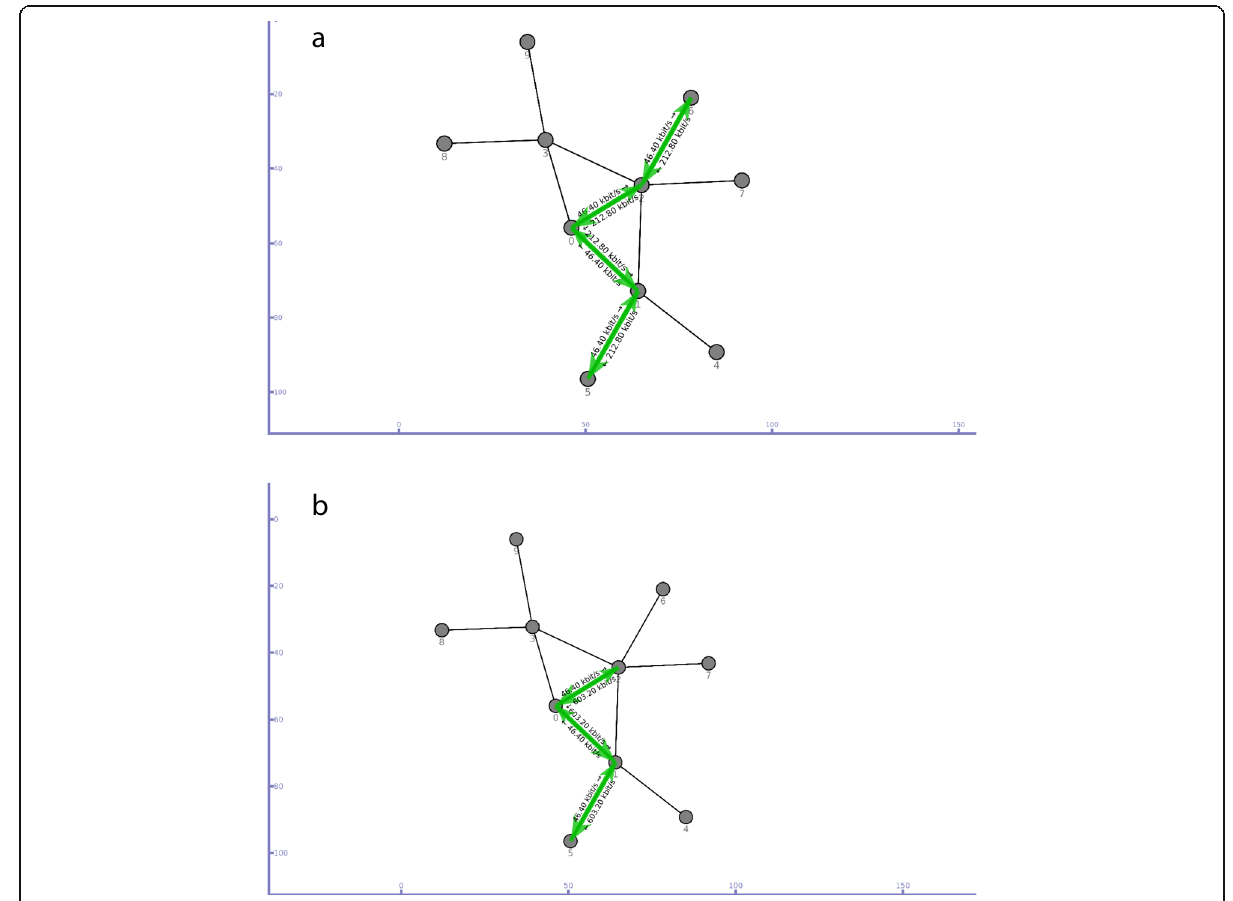
Fig. 4 Throughout of CCN-IoV: a throughout in the V2V communications and b throughout in the V2R